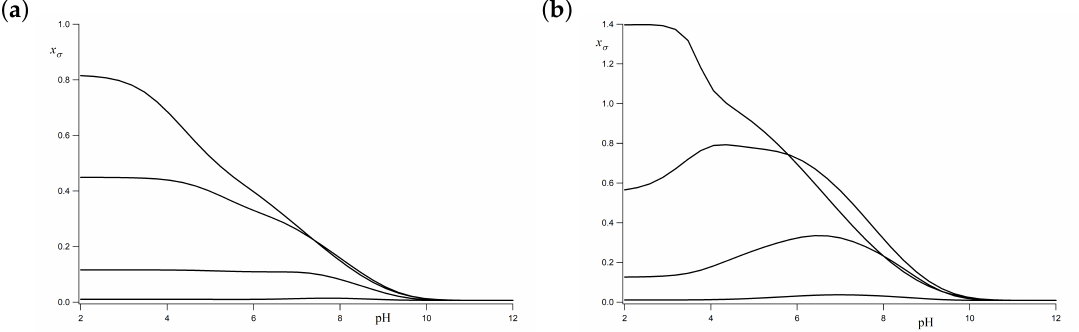
Figure 7. Correction to the gauche state energy x σ versus the pH for p K = 9, (cid:101) t = 1, u g = 0 and σ = 1 ( a ); σ = 10 ( b ). From the bottom to the top, the ionic strengths are 1 M, 0.1 M, 0.01 M and 0.001 M. x σ represents the average effective energy “felt” by c bonds as a result of the LR interactions.